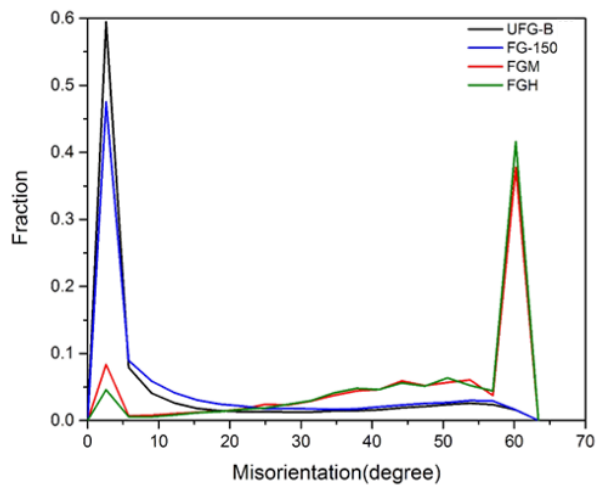
Figure 4. Misorientation angle distribution from EBSD results for the UFG-B [9], FG-150 [9], FGM, and FGH Cu before DTE tests.